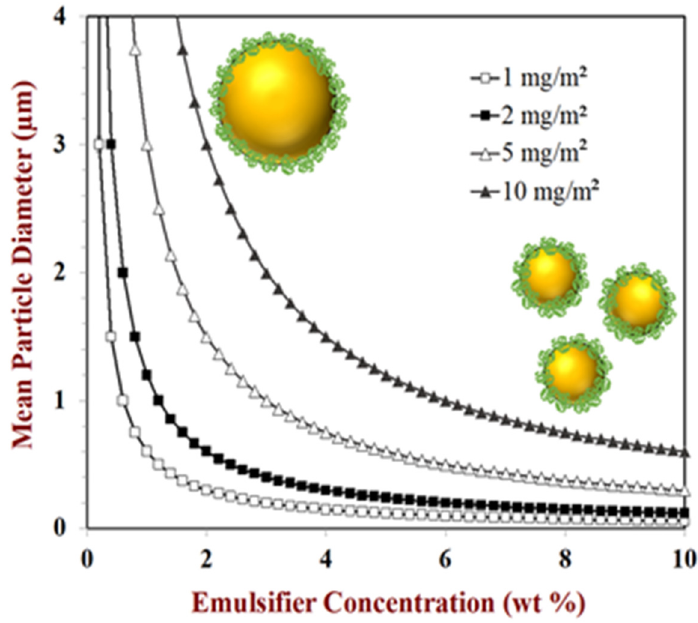
Figure 4. Under conditions where the droplet size is limited by the amount of emulsifier present (rather than the homogenizer operating conditions), the mean droplet diameter decreases with in- creasing emulsifier concentration. Here, the mean particle diameter ( d 32 ) is plotted against emulsifier concentration for emulsifiers with different surface loads. Predictions were made using Equation (2).